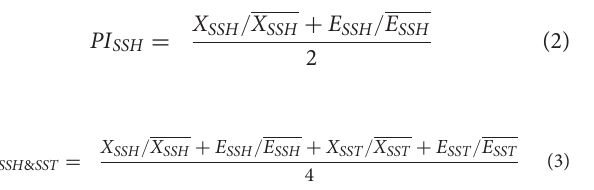
experiment. The top 2 models, IPSL-CM5A-LR and IPSL-CM5A- MR, were selected based on minimum EPI SSH . NorESM1- M and MPI-ESM-LR which showed minimum EPI SSH&SST , a coarser horizontal grid resolution ( ∼ 2.0 ◦ ; Dufresne et